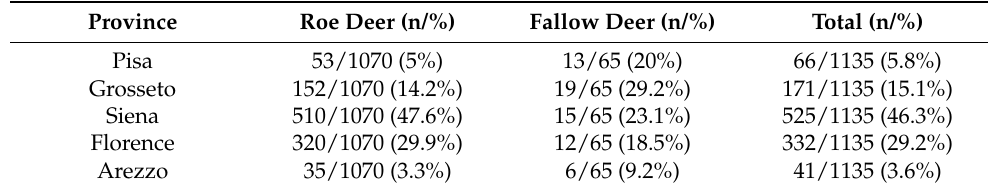
Table 1. Rescue areas details covered by the